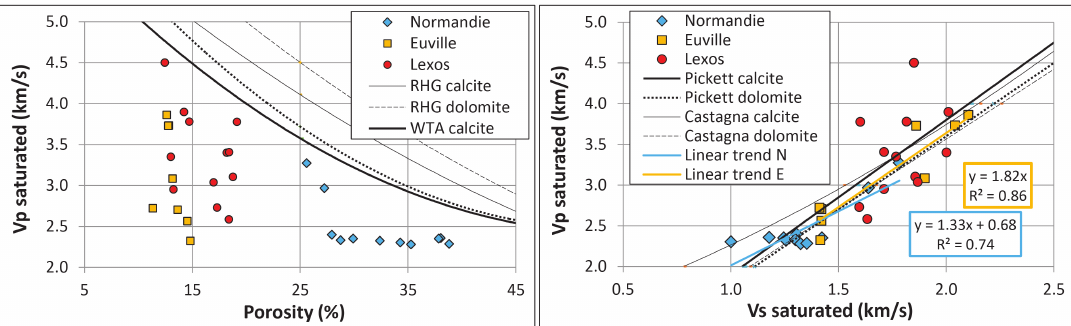
Figure 12. Left : P-wave evolution with porosity. Right : P-wave evolution with S-wave